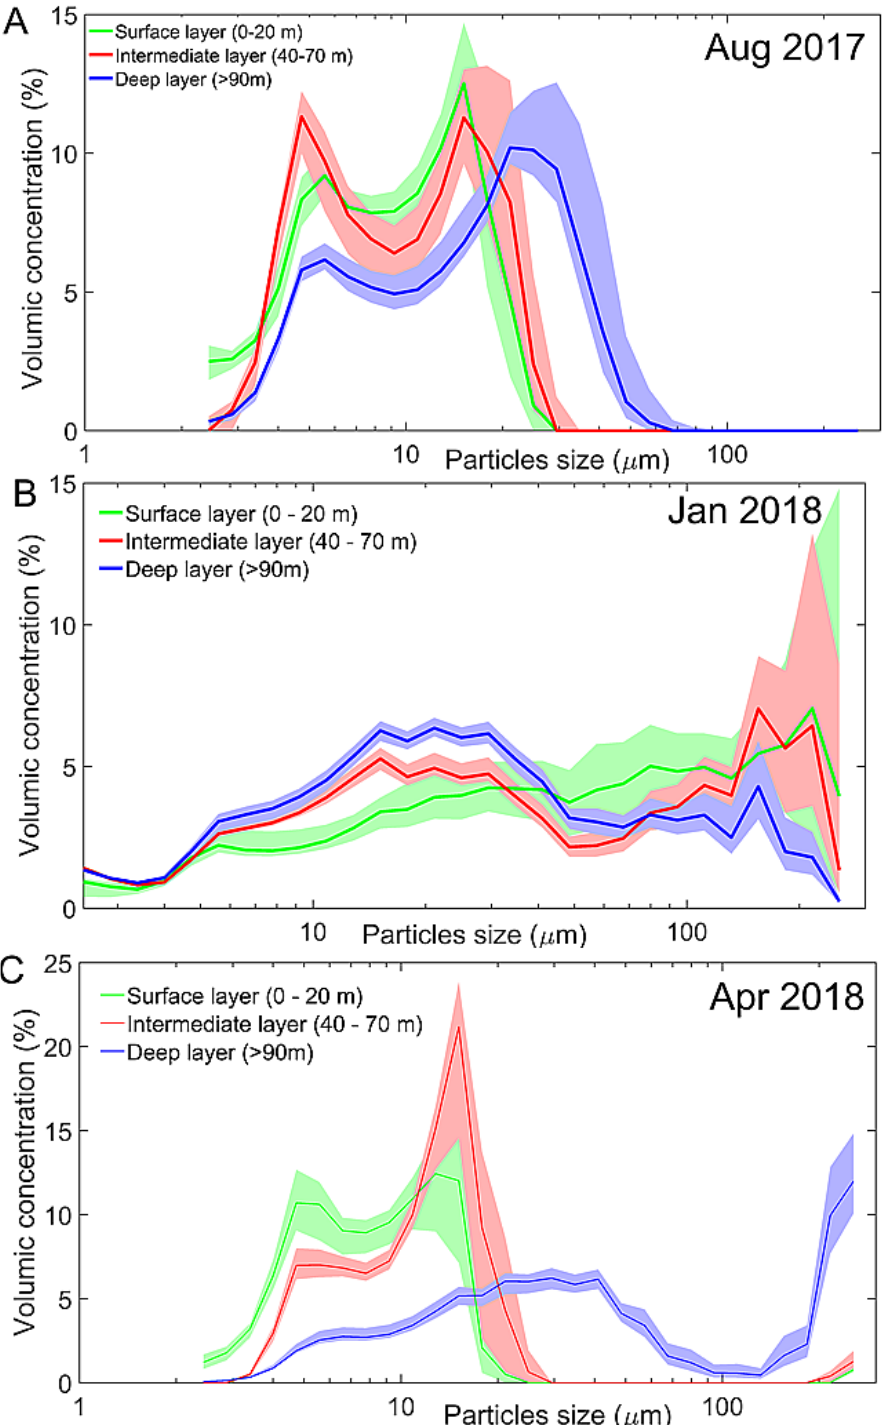
Figure 8. PSD in the surface (green, 0–20 m), intermediate (red, 40–70 m) and deep (blue, 90 m–bottom) layers for all stations of the section across the bay for ( A ) August 2017; ( B ) January 2018; and ( C ) April 2018. The thick lines represent the median values, and the light-colored envelopes represent the 25% and 75% percentiles.